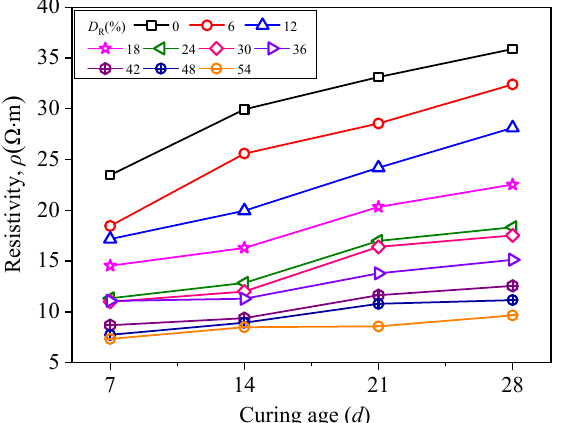
Figure 14. Relationship between resistivity and curing age.